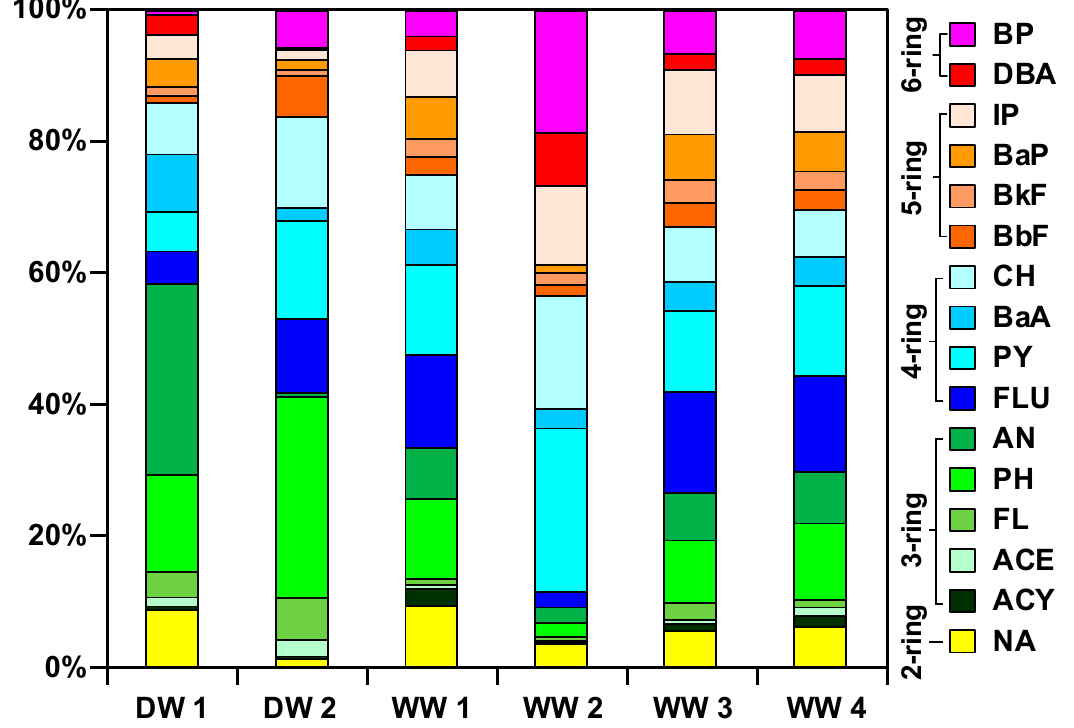
Figure 4. PAHs composition in sludge samples of selected DWTP (DW1–DW2) and WWTP (WW1–WW4). The definitions of compound abbreviation see Table 2.